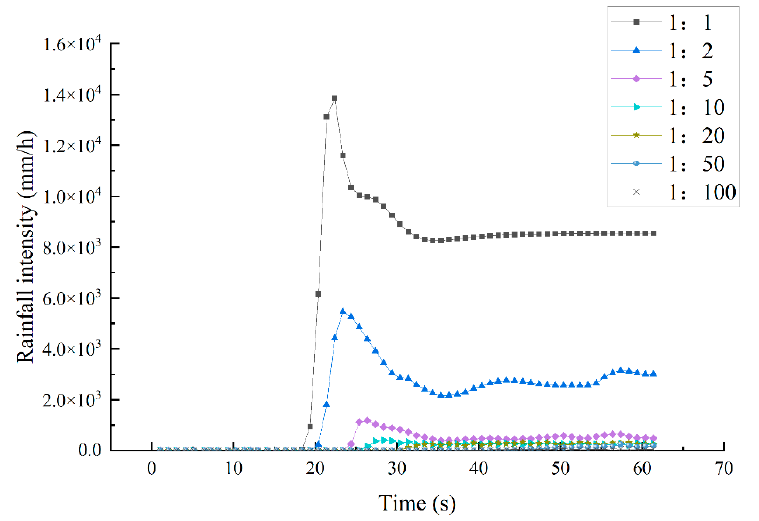
Figure 9. Change process of atomized rain intensity over time under different similarity scales.